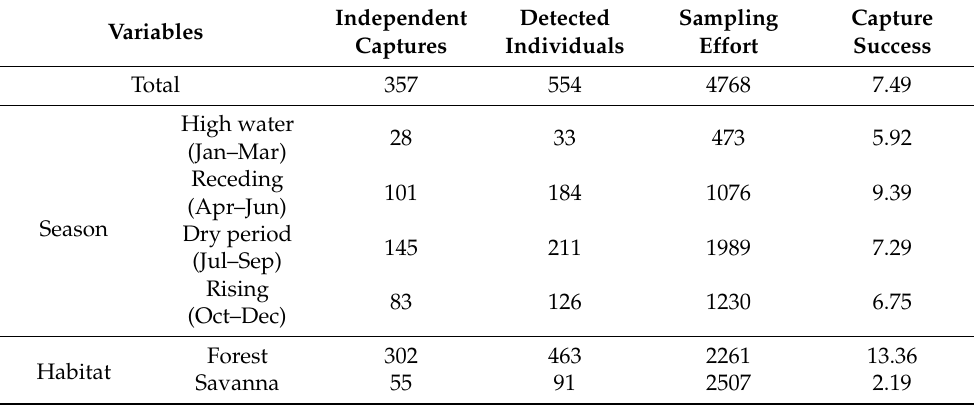
Table 1. Number of independent captures (presence of species based on 30 min independence interval) followed by number of individuals detected in those captures (based on 30 min independence interval), sampling effort (sampling days—24 h cycles), and capture success (number of independent captures per 100 sampling days) of Bare-faced Curassow ( Crax fasciolata , BFC) obtained in the Northern Pantanal (Mato Grosso, Brazil) from July 2015 to December 2017, grouped by habitat dominance (forest/savanna) and seasonal periods defined by water regime (high water, receding, dry period, and rising). Variables